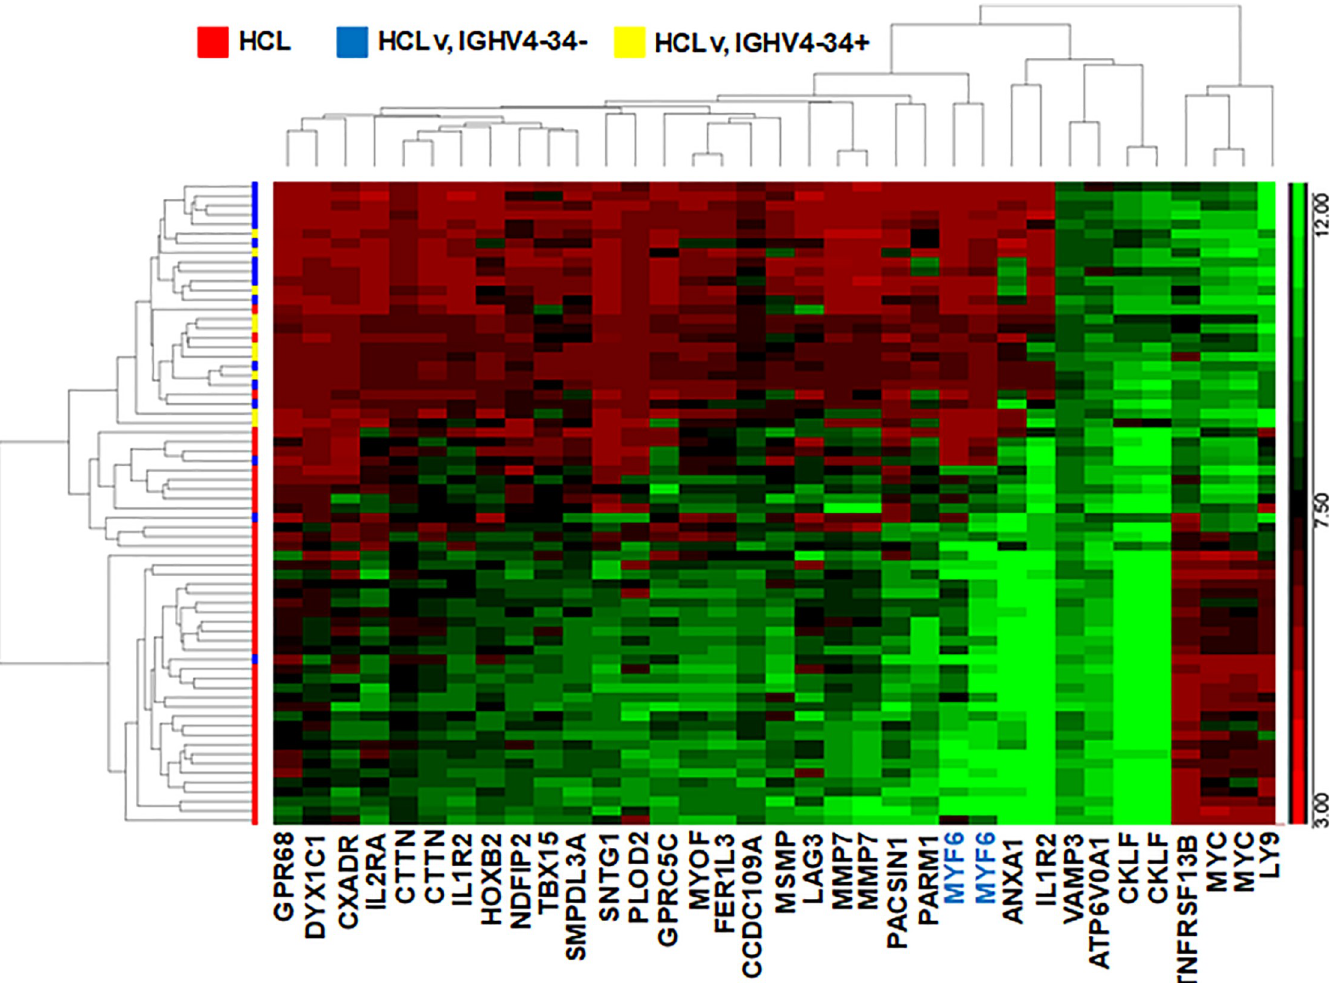
Fig 2. Heat map showing microarray results in HCL and HCLv. The 22 probes for 18 genes most different between HCL and HCLv are shown. The 2 groups compared included HCL and HCLv. HCLv patients with and without the IGHV4-34 IgH rearrangement are indicated in yellow and blue,